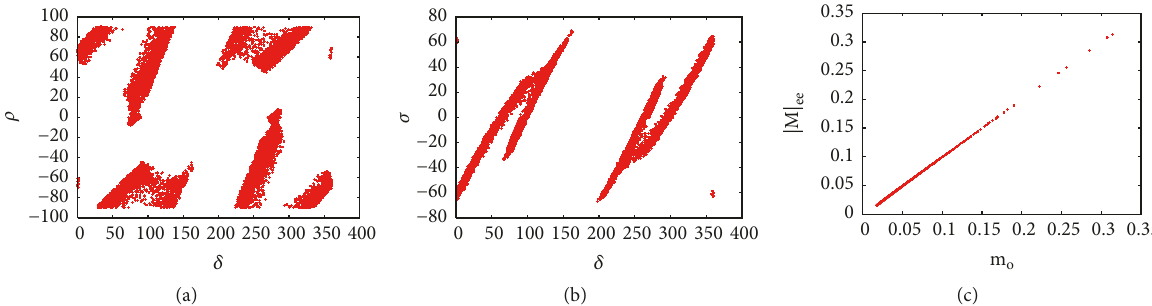
Figure 7: Correlation plots for texture 𝐷 7 (NS) for type X at 3 𝜎 CL. The symbols have their usual meaning. 𝛿, 𝜌 , and 𝜎 are measured in degrees, while |𝑀| 𝑒𝑒 and 𝑚 0 are in eV units.